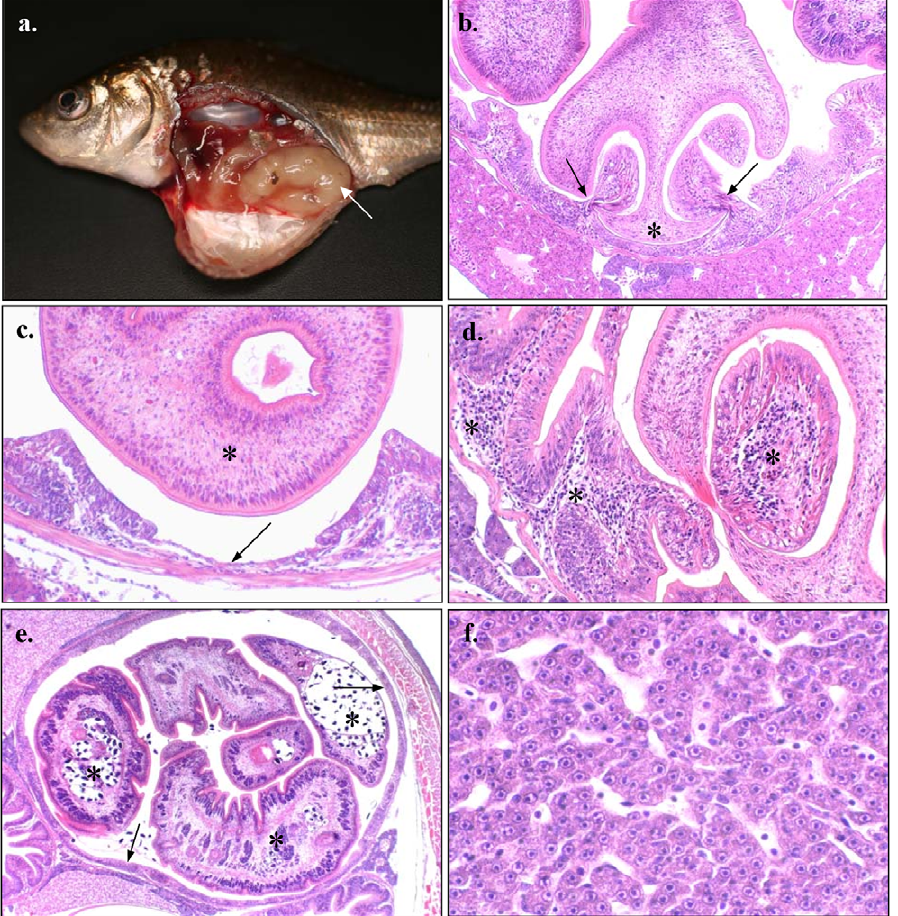
Figure 1. Histopathology of Cyprinuscarpio intestines infected with Bothriopcephalusacheilognathi . (a) Young-of-the-year Cyprinus carpio parasitized with Bothriopcephalus acheilognathi showing enlarged, transparent and occluded intestine (arrow); (b) attachment of B. acheilognathi involving the two bothria located on each side of the scolex pinching the intestinal folds (arrow). This forced the apex of the scolex (*) firmly against the gut wall; (c) pressure exerted by the scolex (*) created indentations within the intestine, with loss of mucosa and pronounced thinning of the gut wall (arrow); (d) marked inflammatory response to B. acheilognathi infection with an increase in lymphocytes throughout the lamina propria (*); (e) B. acheilognathi proglottids (*) within the anterior intestine of common carp, causing pronounced intestinal distension, compression of intestinal folds (arrows) and extensive loss of normal gut architecture; and (f) Atrophy of hepatocytes throughout the liver of parasitized common carp, consistent with reduced nutritional